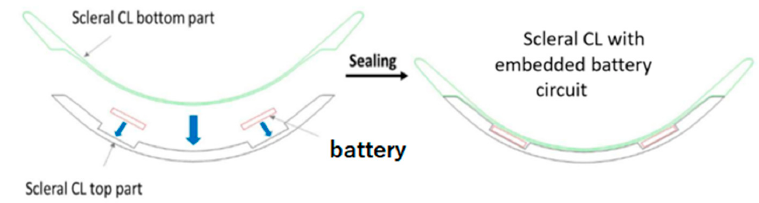
Figure 3. Principle of the battery encapsulation in a scleral contact lens (from LCS).